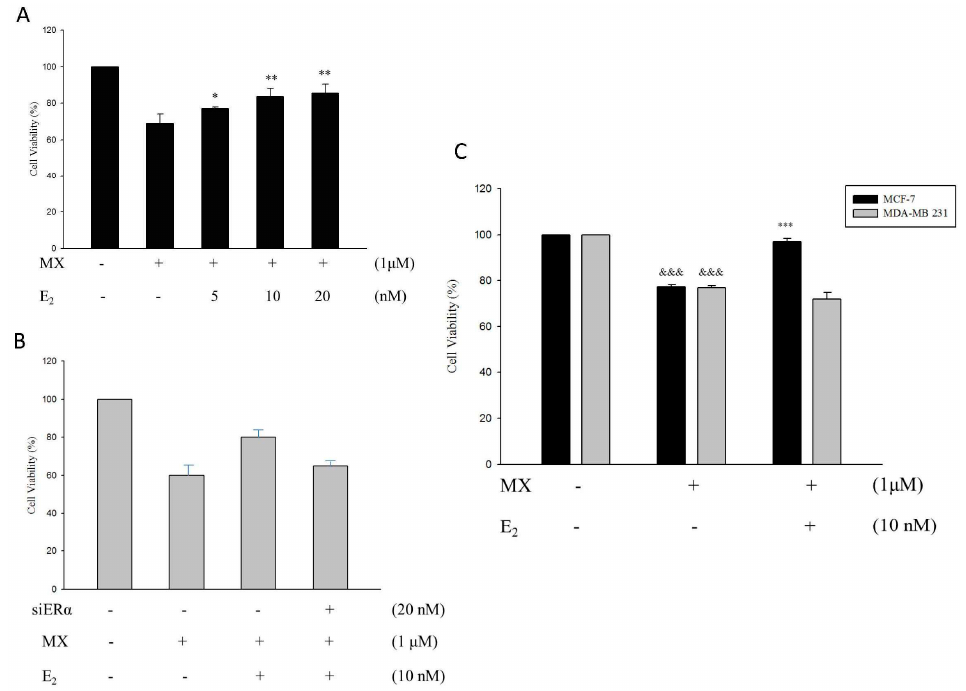
Figure 7. E2 reduces the cell death caused by MX in a dose-dependent manner in normal MCF-7 cell line. ( A ) E2 increased the cell viability in a dose-dependent manner which were co-treated with l µM MX in normal MCF7 cells.* p < 0.05, ** p < 0.01 indicate significant differences compared to the control group; ( B ) siER α inhibited the cell viability of normal MCF7 cells (l µM MX treatment) compared to the control group (E2 only) (+ represents the addition; - represents not addition); ( C ) E2 was treated with l µM MX in MCF7 cells and MDA-MB231 cells. The cell viability increased 25% in the E2 treatment group compared to the control group (MX only) in normal MCF7 cells while there was no significant difference in MDA-MB231 cells. &&& p < 0.001 indicates significant differences compared to the control group and *** p < 0.001 indicates significant differences compared to the MX treatment group.